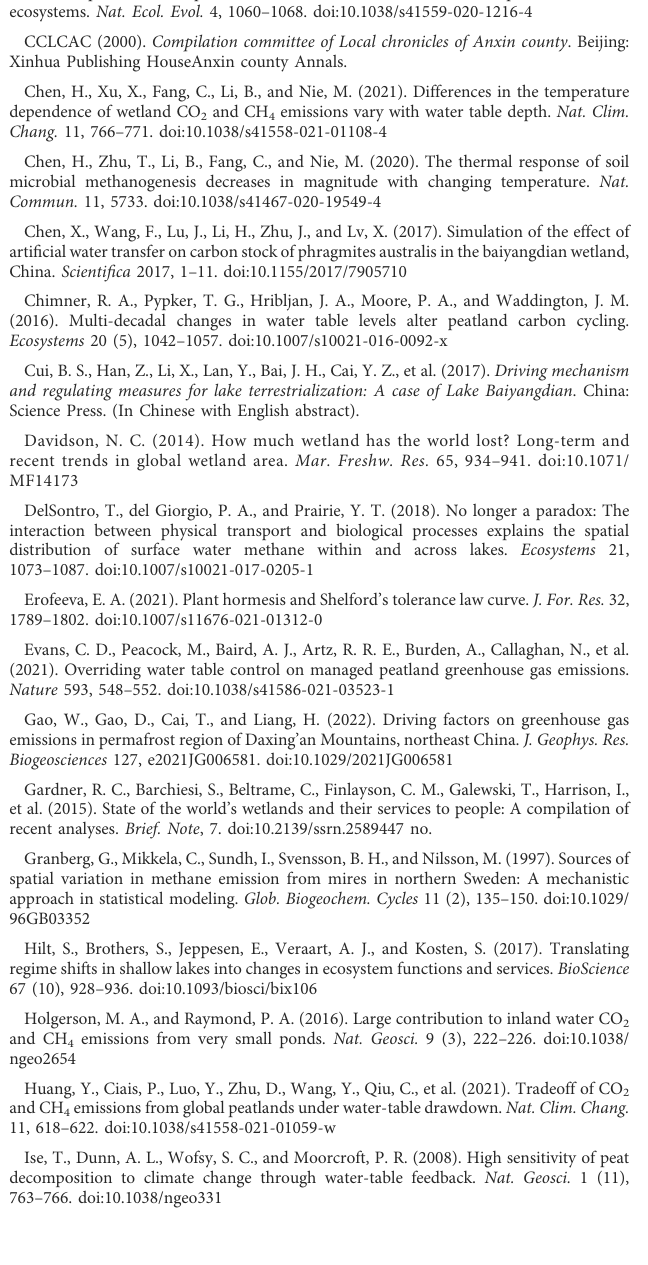
SUPPLEMENTARY FIGURE S1 Annual mean state of the spatial distribution (Figure S1A) and frequency distribution (Figure S1B) of water depth from 1960 to 2019, and frequency distribution (Figure S1C) of sample sites water depth in fi eld